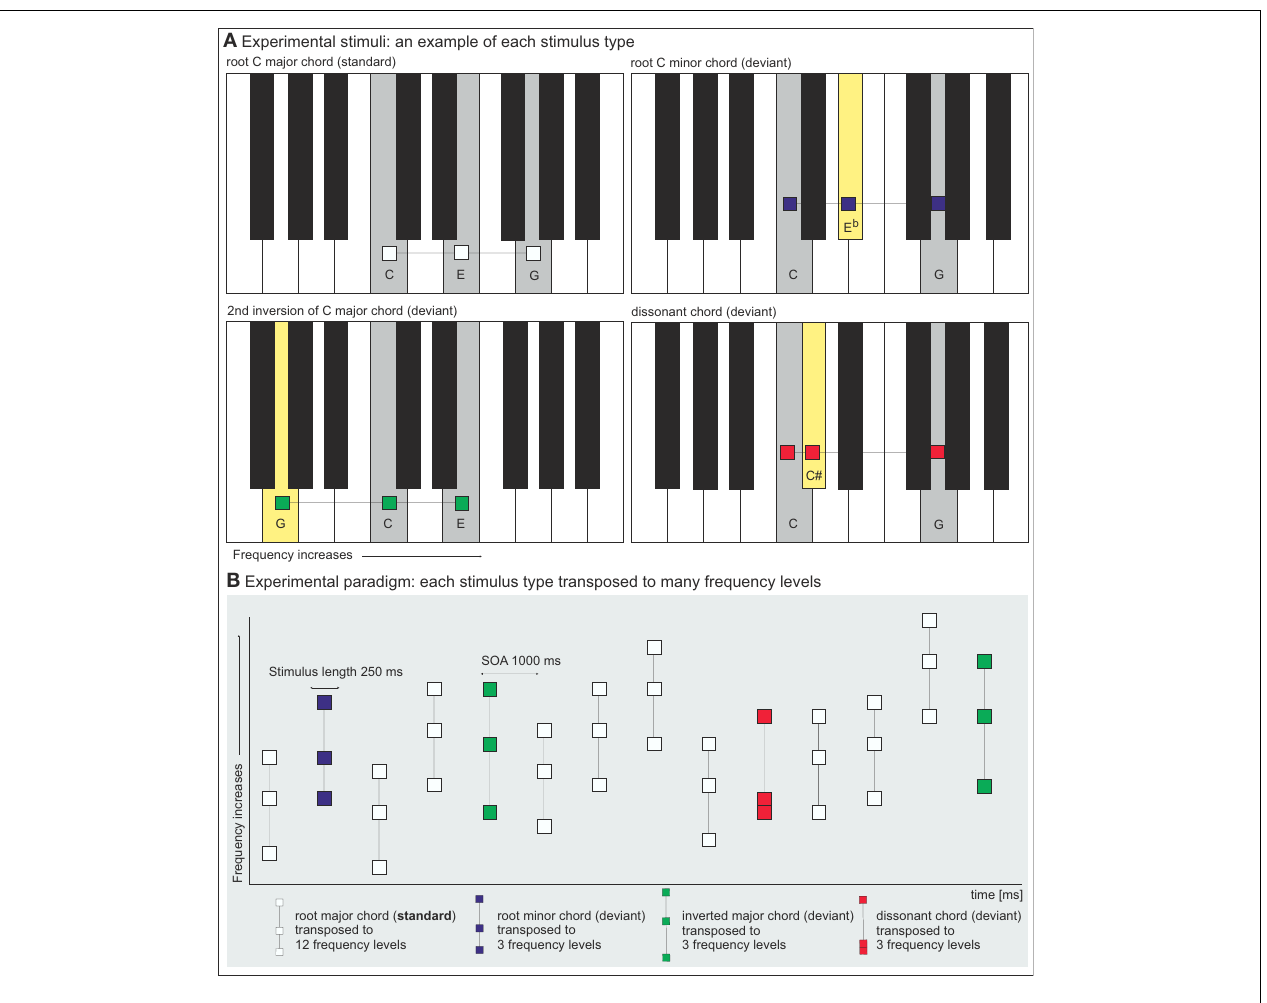
FIGURE 1 | (A) Experimental stimuli. One example of each stimulus type illustrated with gray-shaded keys on the piano keyboard. The yellow key illustrates the deviant chords’ difference from the root major chord (standard). (B) Experimental paradigm. The oddball